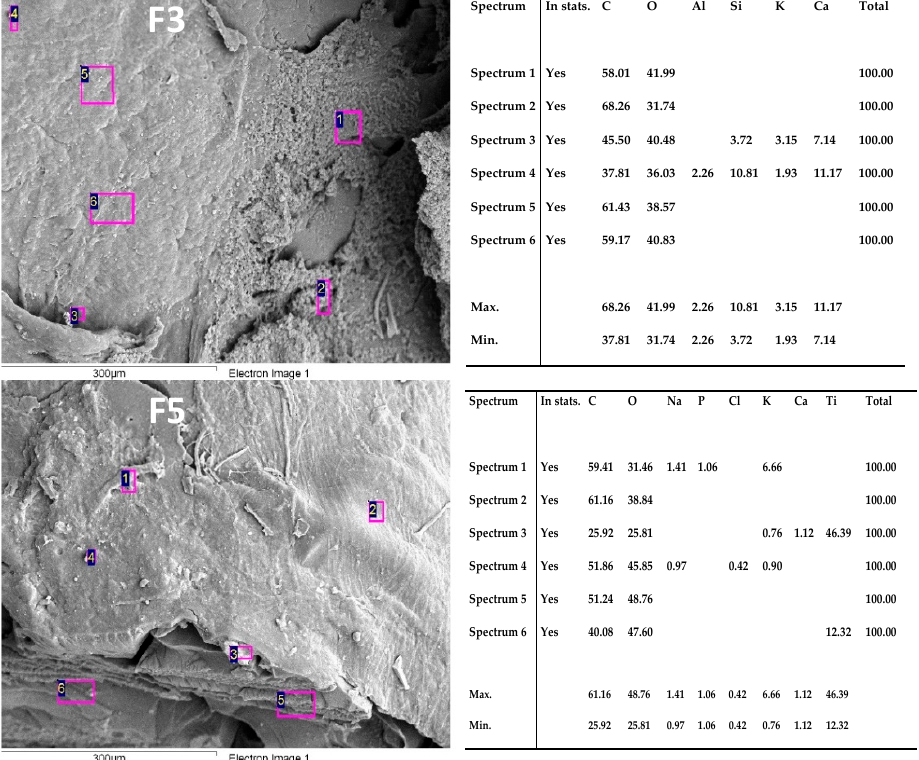
Figure 7. SEM-EDS analysis for F3 and F5 formulations inside after bone implantation studies.